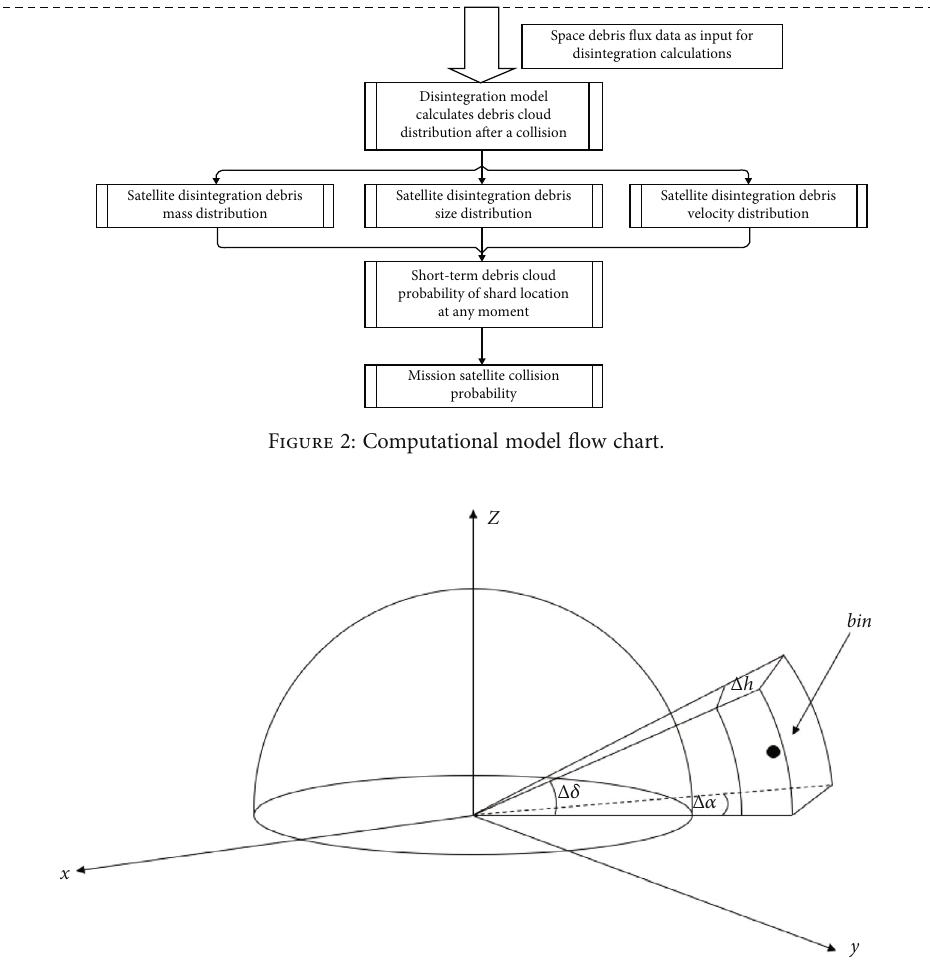
Figure 3: Bin ’ s spatial